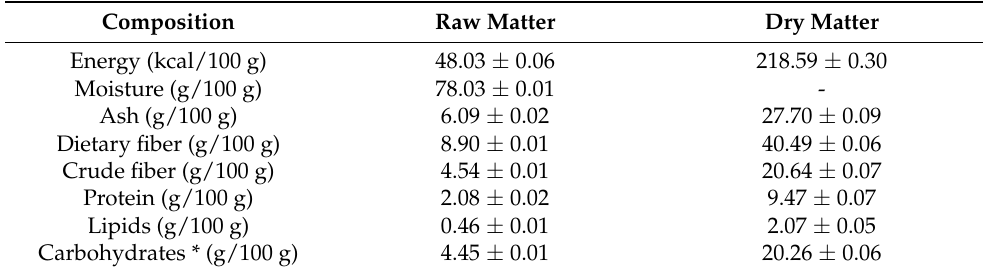
Table 1. Nutritional composition of Halminione portulacoides . Composition Raw Matter Dry Matter Energy (kcal/100